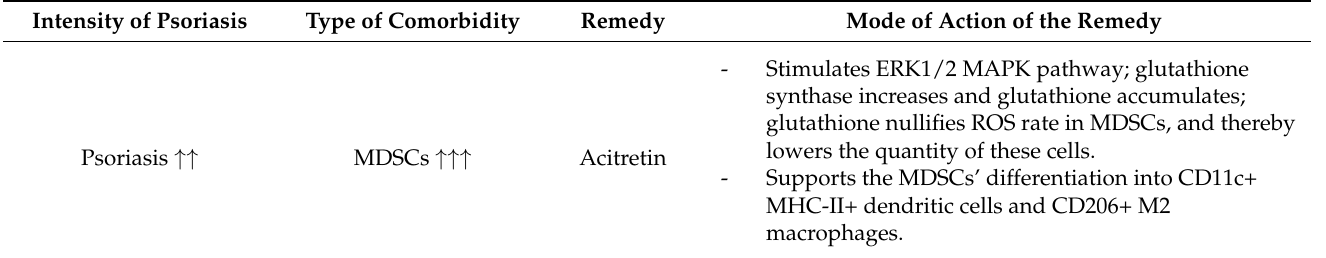
Table 11. Role of acitretin in reducing myeloid-derived suppressor cells (MDSCs) in the psoriatic animal